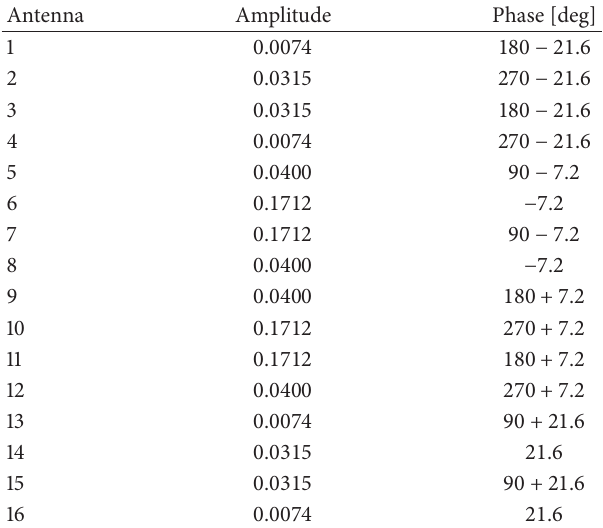
Figure 3: Nonuniform series divider 𝑆 in , in results for both open ring and open octagon implementations.